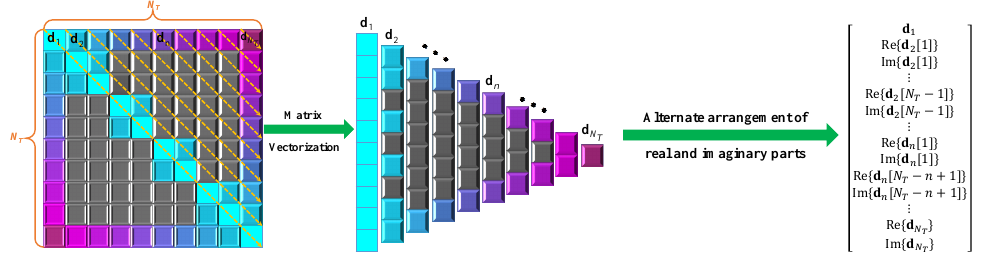
Figure 4. Vectorization of the upper triangular part of (cid:98) R .